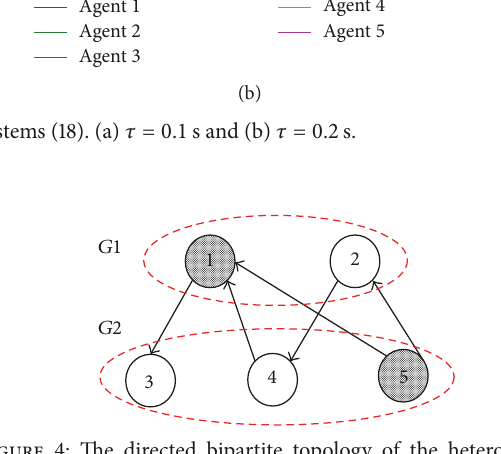
Figure 4: The directed bipartite topology of the heterogeneous